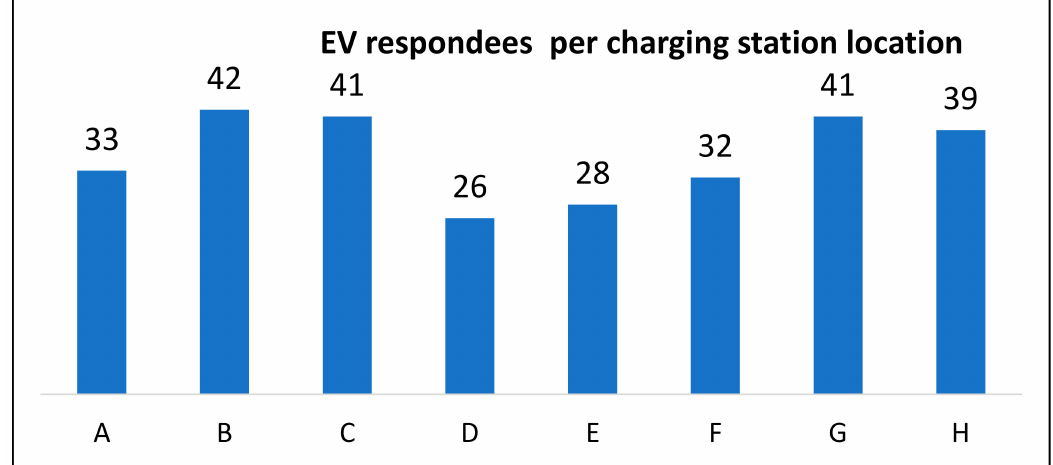
Figure 13. Primary survey investigation at 8 locations. September–October